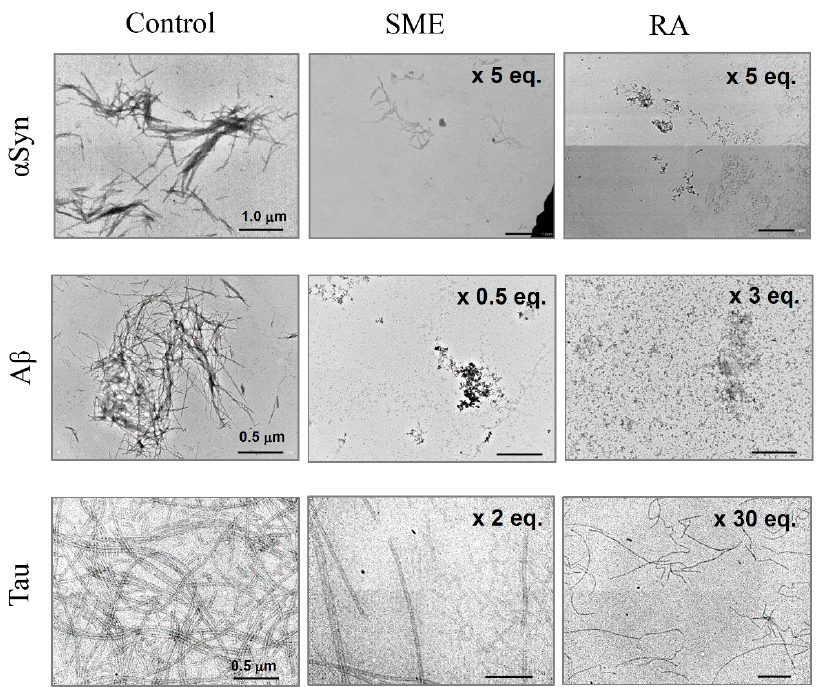
Figure 4. Transmission electron microscopy (TEM) measurements of amyloid fibrils of α-synuclein (αSyn), amyloid beta (Aβ), and Tau incubated with spearmint extract (SME) or pure rosmarinic acid (RA). αSyn, Aβ, and Tau amyloid fibril peptides were incubated with SME (5, 0.5, or 2 equivalent molar RA to each peptide) or pure RA (5, 3, 30 equivalent molar to each peptide) for the respective intervals (40 h for αSyn, 12 h for Aβ, and 25 h for Tau), after which samples were treated for observation with TEM. Scale bars, 1.0 μm on αSyn images, 0.5 μm on Aβ and Tau images.